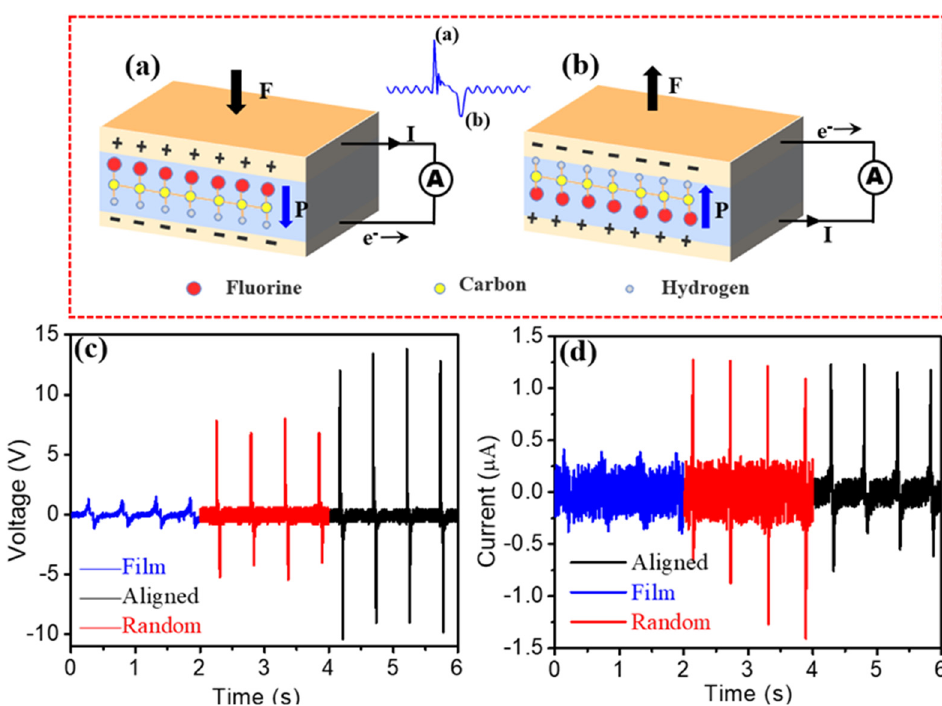
Figure 4. Working mechanism of the piezoelectric nanogenerator, stress applied ( a ) and released ( b ); output voltages ( c ) and short-circuit current signals ( d ) of the flexible nanogenerators assembled by thick film, r-PVDF, and highly a-PVDF membranes, respectively.